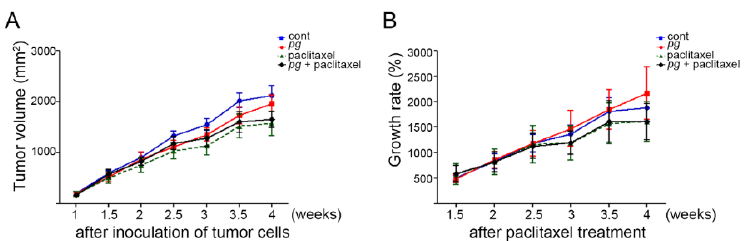
Figure 3. Comparisons of tumor volume and growth rate between P. gingivalis -treated and/or paclitaxel-treated mice administered ibuprofen. Tumor volumes ( A ) were measured twice per week after the subcutaneous implantation of tumor cells, and ibuprofen was administered in drinking water. The growth rate of the tumor masses ( B ) was calculated. Data are presented as the mean ± standard deviation. Significance was assessed using ANOVA. * P < 0.05.